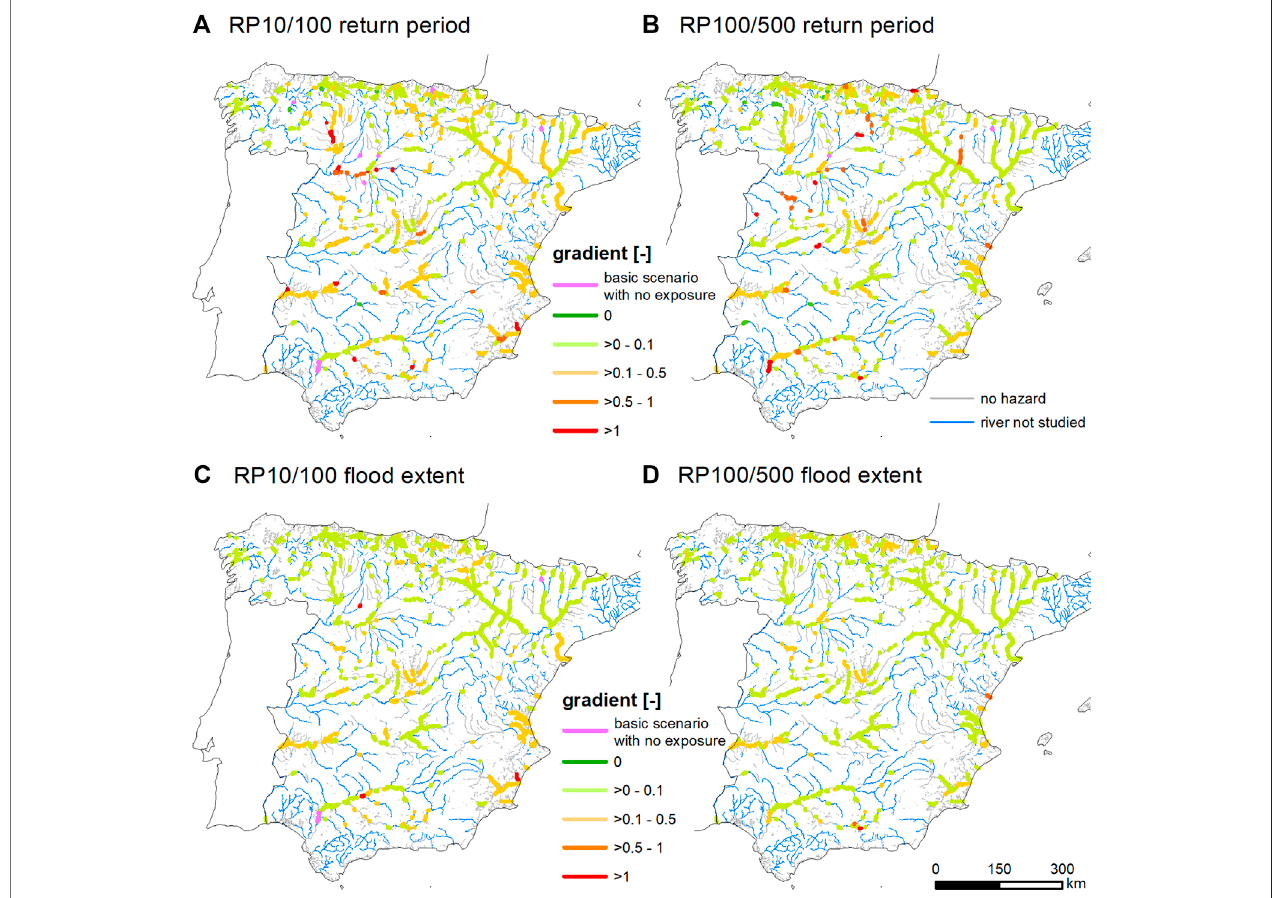
FIGURE6| Sensitivityofpopulationexposuretochangesinthe fl oodmagnitudeofthemainriver fl oodplainsofSpain: (A) Normalizedgradientbetweenanincrease intheexposedpopulationandanincreaseinthefrequencyfromdownwardcounterfactualanalysisofa1-in-10 yearsdesign fl ood. (B) Normalizedgradientderivedfrom downward counterfactual analysis of a 1-in-100 years design fl ood. (C) Normalized gradient between an increase in the exposed population and an increase in fl ood extentfromthedownwardcounterfactualanalysisofa1-in-10 yearsdesign fl ood. (D) Normalizedgradientderivedfromthedownwardcounterfactualanalysisofa 1-in-100 years design fl